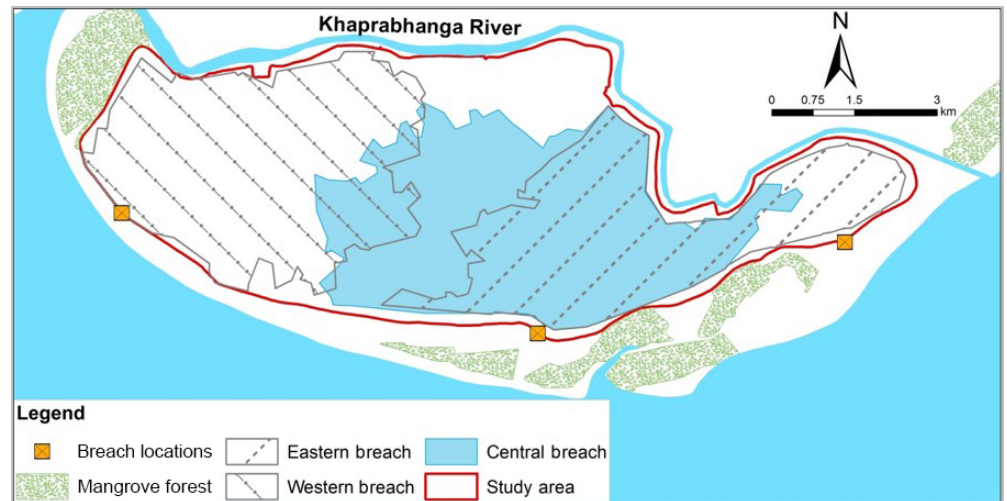
Figure 8. Flood extent corresponding to three worst-case scenarios of dike breaching in the central, eastern and western section of the dike.